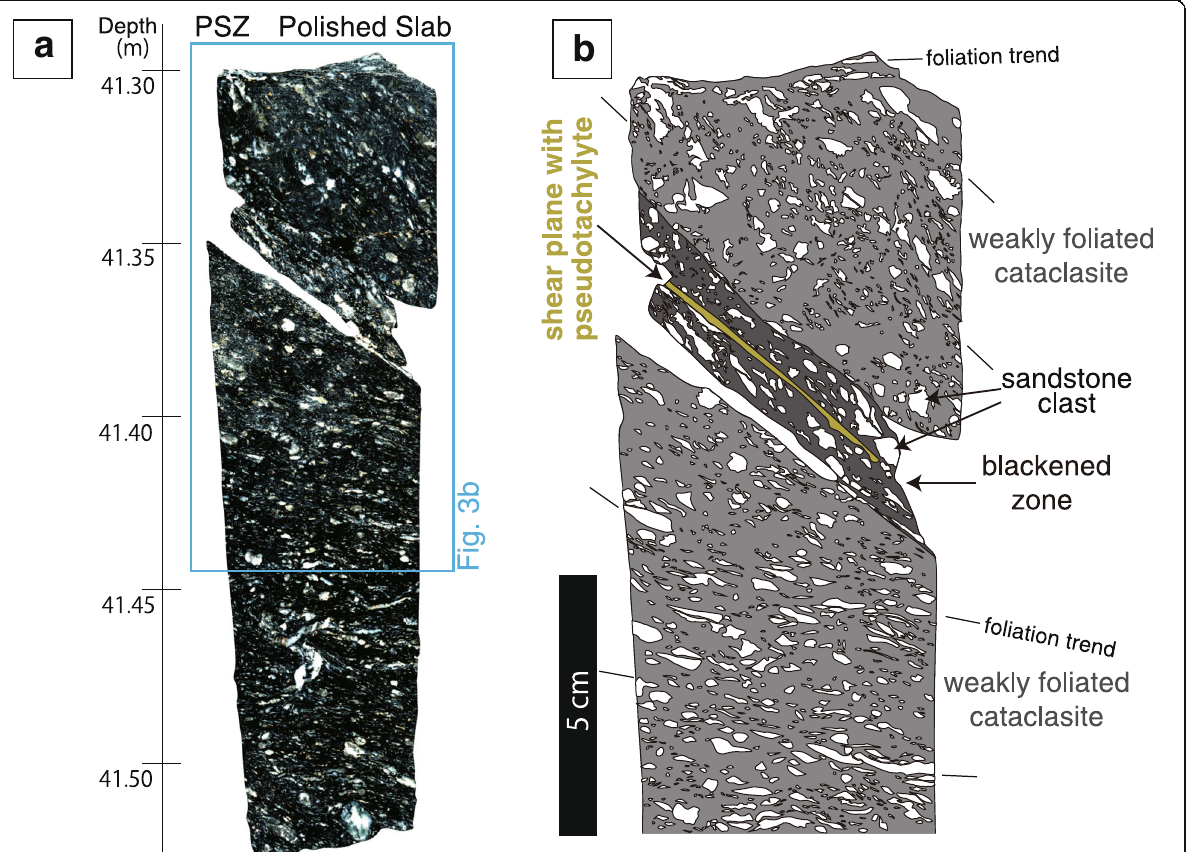
Fig. 3 Internal structure of the PSZ. a A photograph of polished slab of the PSZ. Polished slab is 24 cm long and 5 – 7 cm wide. Blue square shows the area of the sketch (Fig. 2b). b Sketch of polished slab of the PSZ. PSZ is composed of foliated cataclasite including sandstone clast. Foliated cataclasite is truncated by sharp shear plane accompanying blackened zone. The shear plane is composed of